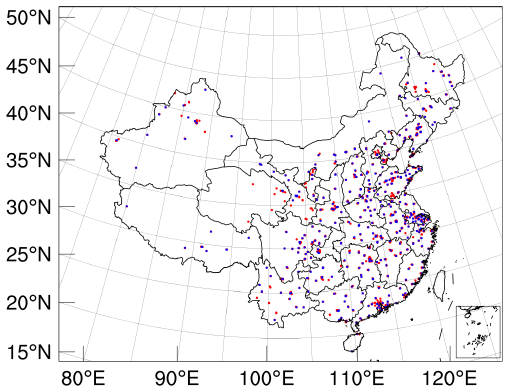
Figure 3. The locations of the 1425 SO 2 assimilated and 508 inde- pendent verification observation stations of the CNEMC are shown by the red and black dots, respectively. Inset: South China